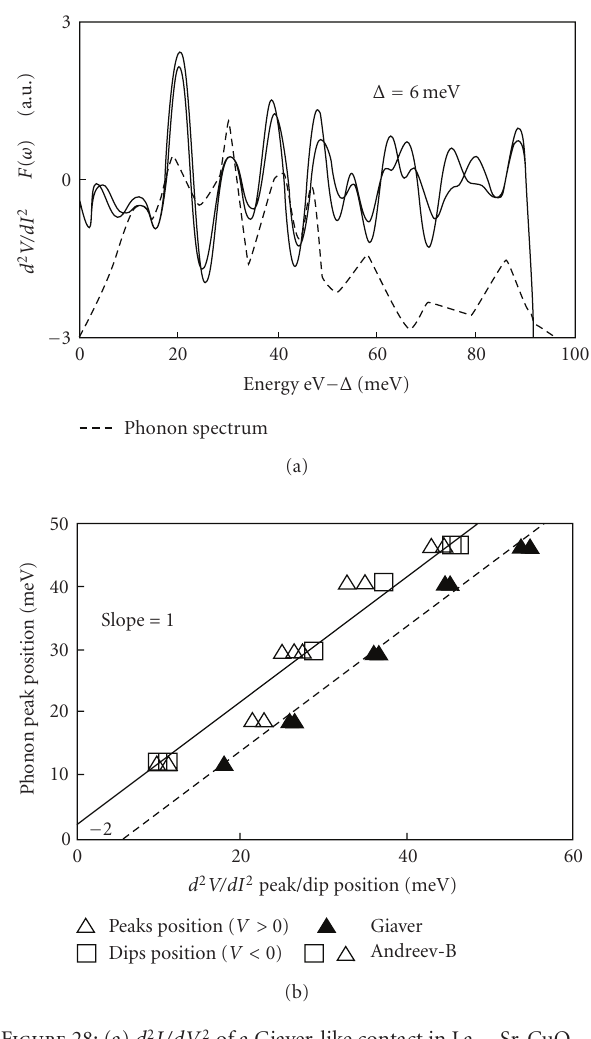
Figure 28: (a) d 2 I/dV 2 of a Giaver-like contact in La 2 − x Sr x CuO 4 — note the large structure below 50meV; (b) d 2 I/dV 2 of an Andreev- and Giaver-like contact compared to the peaks in the phonon density of states. From [160].